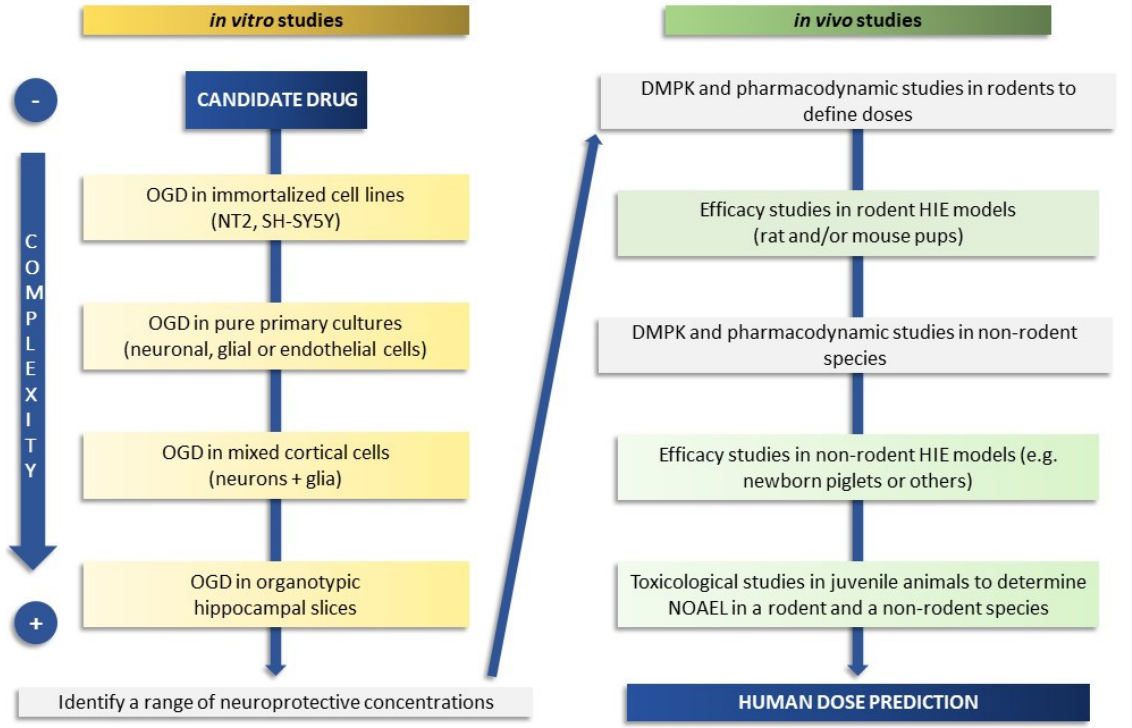
Figure 1. Schematic flow chart of a screening cascade to prove the efficacy of a candidate drug in neonatal HIE. On the left side is depicted a representative test cascade for evaluating the efficacy in